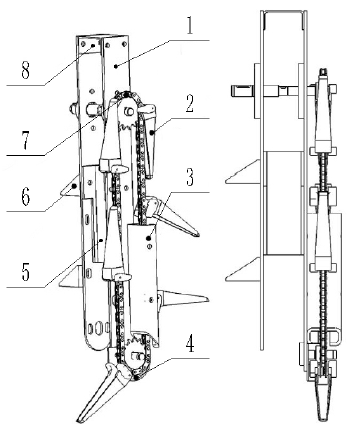
Figure 17. Structural diagram of chain row teeth claw righter for ratoon rice. 1. Chain row devices; 2. Tooth claw righter; 3. Righting top plate; 4. Arc top plate; 5. Chain row connecting devices; 6. Chain row hanging device; 7. Chain; 8. U-shaped fixed plate.